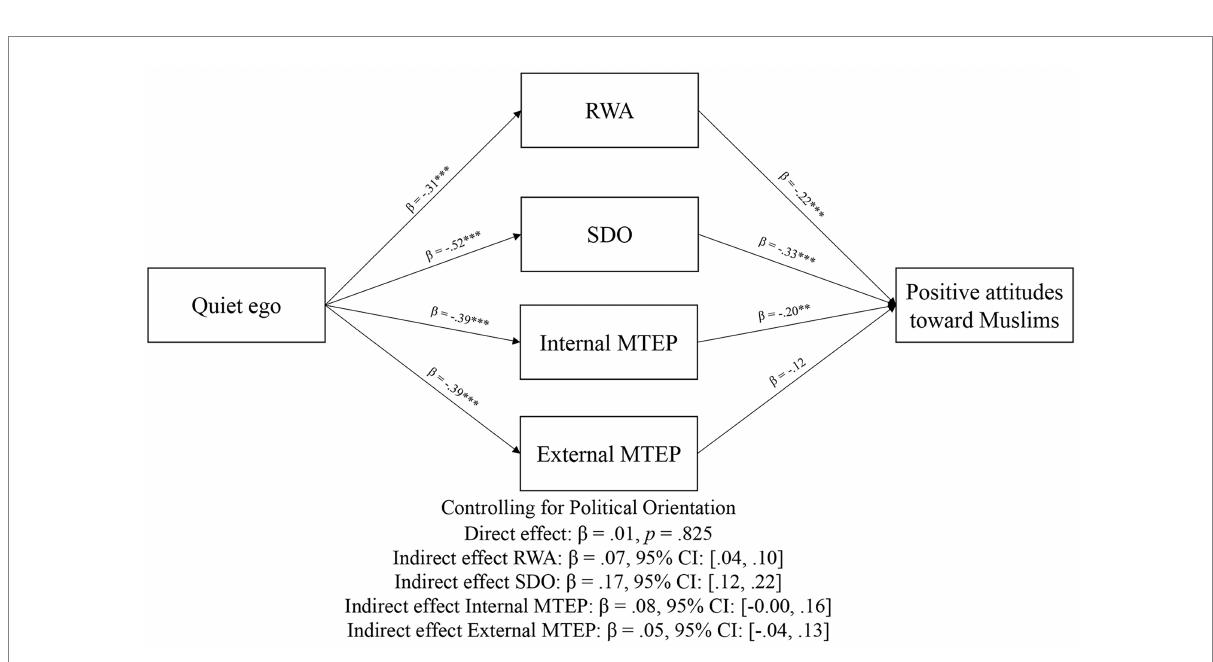
FIGURE 3 Mediation results from Study 2, controlling for political orientation. ** p < 0.01; and *** p <